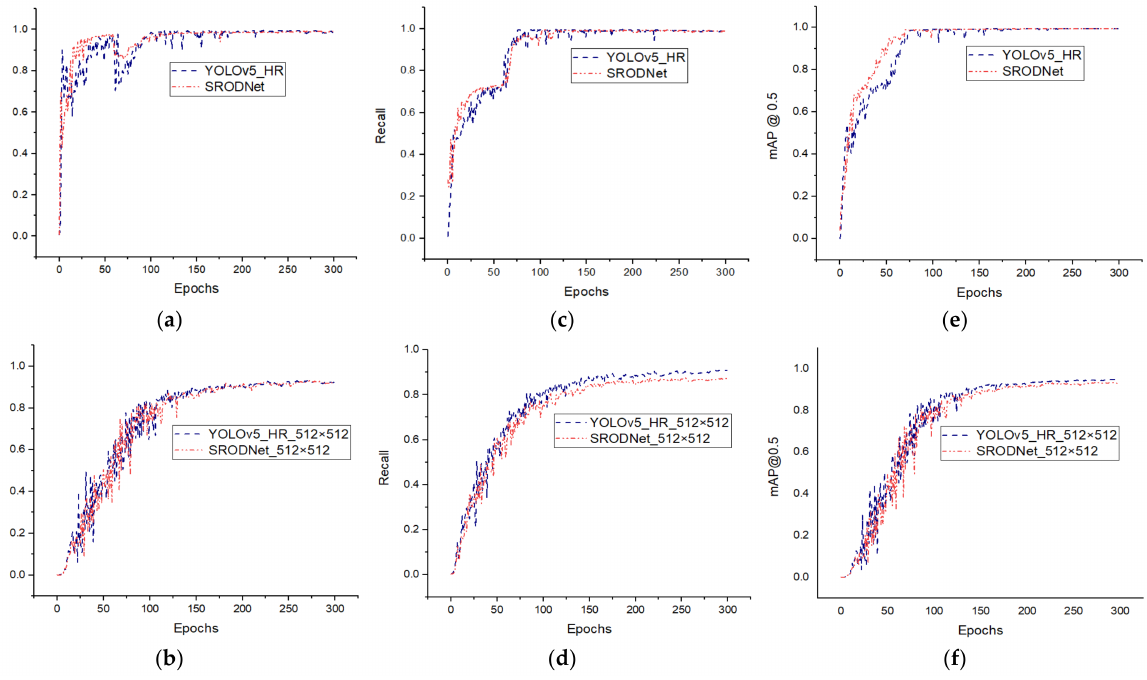
Figure 7. Precision, recall, and mAP @ 0.5 curves on various datasets, such as KoHT and DOTA: ( a , b ) P-curves, ( c , d ) R-curves, and ( e , f ) mAP @